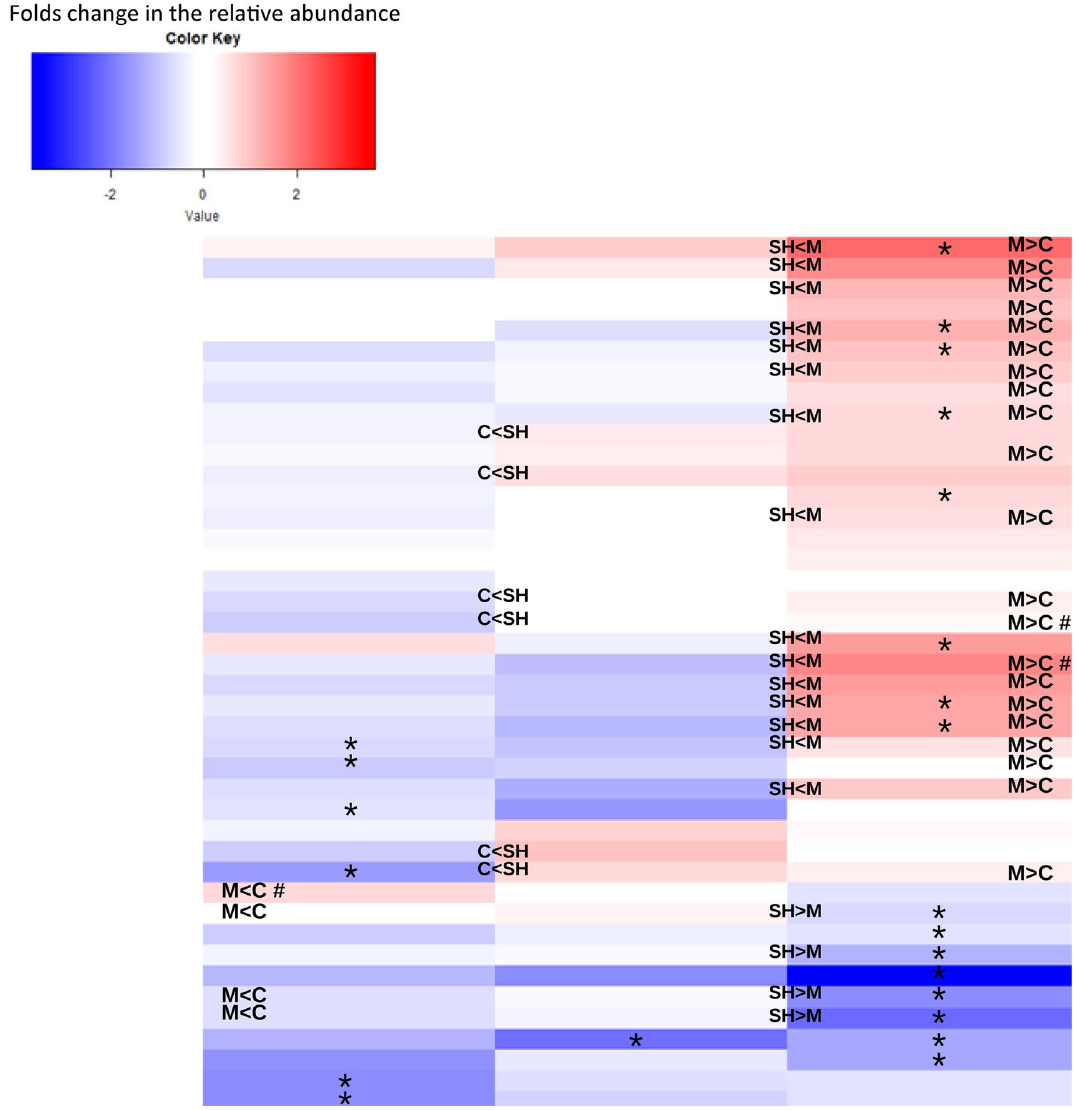
Figure 4. Significant log2 fold change of genera abundances in cigarette, shisha, or medwakh smoking groups compared to non-smokers (log2 tobacco vs log2 non-smokers). Red indicates an increase and blue indicates a decrease in the relative abundance of each genus compared to non-smokers. *Significant difference between each tobacco group and non-smokers; # significant difference exclusively in patients with severe periodontitis; M medwakh smokers, C cigarette smokers, SH shisha